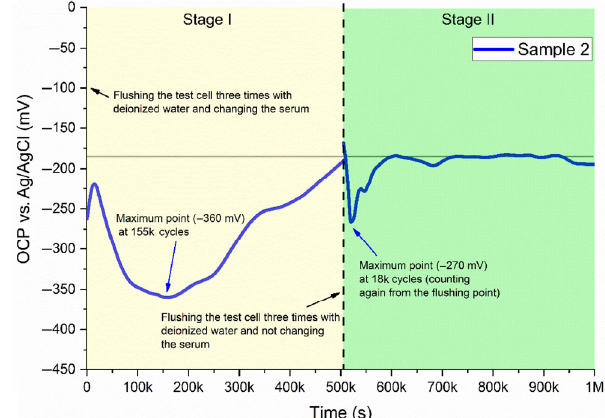
Fig. 5 Variations in the I corrosion currents for MoP THRs corr (Samples 1 and 2) and bearing surfaces (Samples 3 and 4) during 0.5 million cycles.